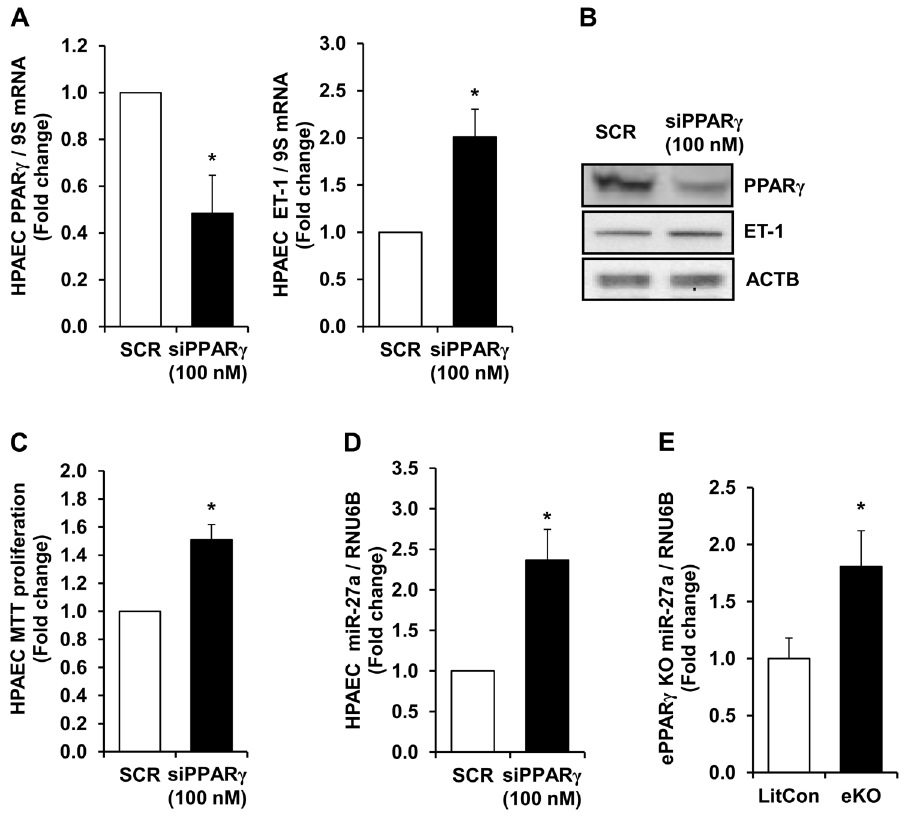
Figure 5. siRNA-mediated reductions in PPAR c increased HPAEC ET-1, proliferation, and miR-27a levels. HPAEC were treated with scrambled (SCR) or siRNA (100 nM) to PPAR c for 72 hours. HPAEC mRNA or proteins were then isolated. In selected studies, HPAEC were subjected to MTT assays of proliferation. A. qRT-PCR was performed demonstrating decreases in PPAR c mRNA levels following treatment with siRNA. Each bar represents the mean 6 SE PPAR c or ET-1 relative to 9S in the same sample expressed as fold-change vs. cells treated with scrambled siRNA (SCR). n=4–9, *p , 0.05 vs. SCR. B. HPAECs were treated with 100 nM SCR or PPAR c siRNA, and proteins were subjected to Western blotting for PPAR c , ET-1, or b -actin (ACTB). As illustrated by these representative Western blots, PPAR c depletion reduced HPAEC PPAR c protein levels, and increased levels of ET-1. C. HPAEC were treated with 100 nM SCR or siPPAR c and subjected to MTT proliferation assays. n=6. *p , 0.05 vs. SCR. D. HPAECs were treated with SCR or siPPAR c , and miRNA was isolated and subjected to qRT-PCR analysis along with RNU6B. Each bar represents the mean 6 SE miR-27a relative to RNU6B expressed as fold changed vs. SCR. n=4, *p , 0.05 vs. SCR. E. miR-27a levels were upregulated in lungs from endothelial-targeted PPAR c knockout (ePPAR c KO) mice. miR-27a levels in lungs from endothelial-targeted PPAR c KO mice were determined with qRT-PCR. Each bar represents the mean 6 SE level of miR-27a relative to RNU6B expressed as fold-change vs. littermate controls (LitCon), n=3–6. *p , 0.05 vs. LitCon.